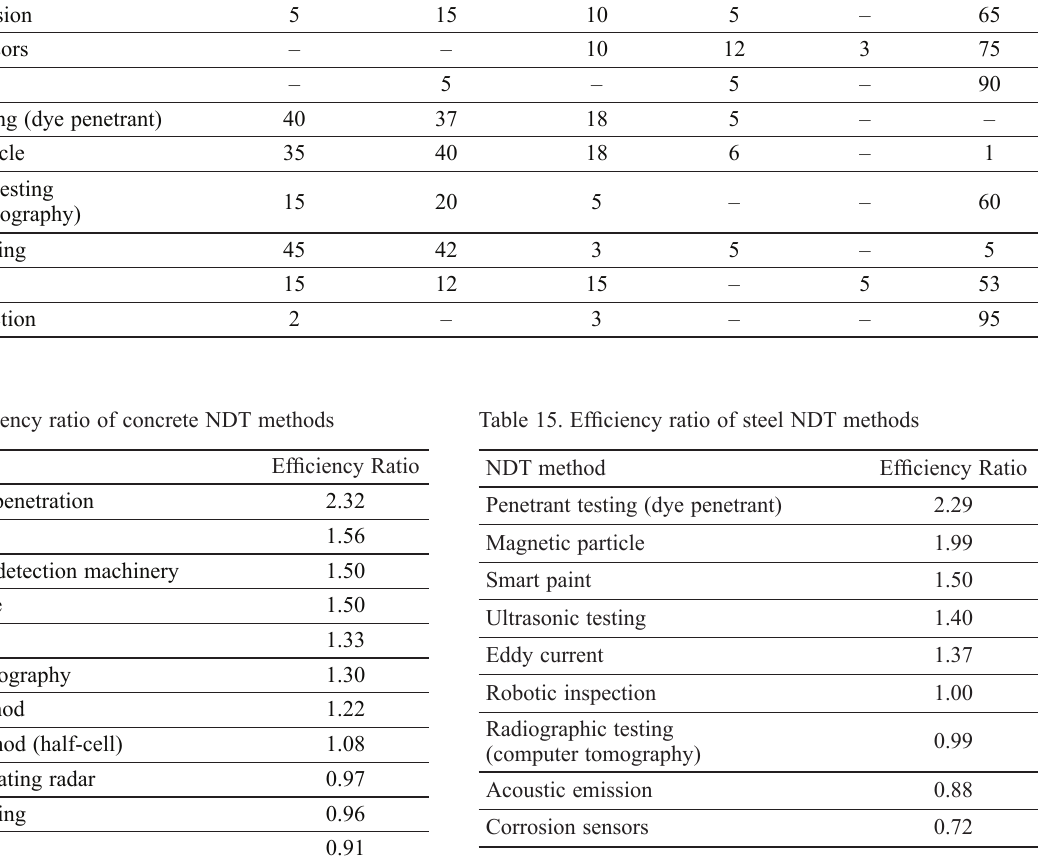
Table 13. Steel NDT methods: effectiveness score NDT method